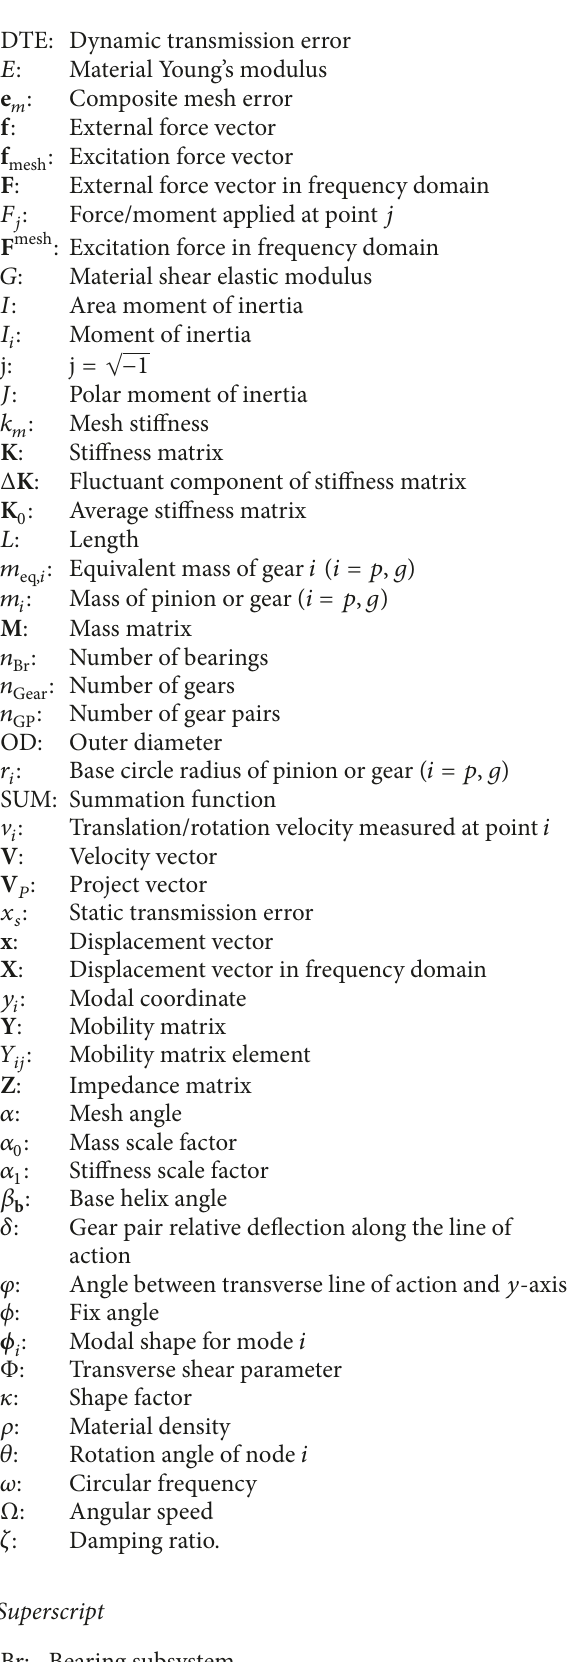
𝑝 : Pinion 𝑡 : Top interface part (in Figure